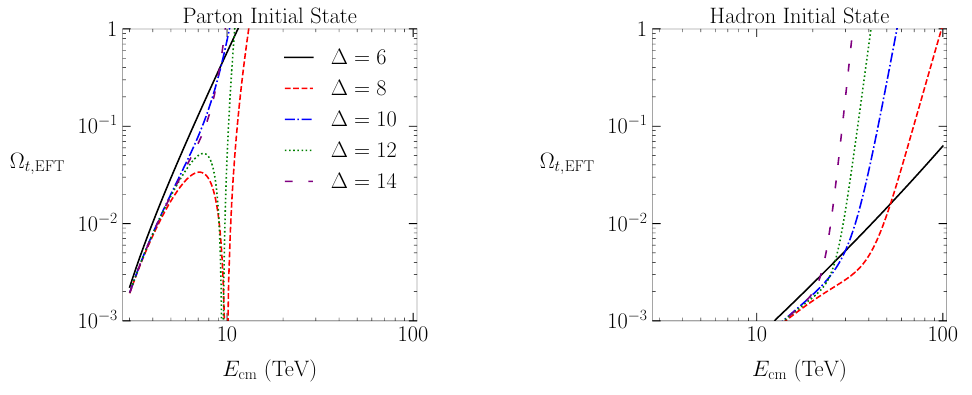
Figure 5 . Ω t, EFT computed using the EFT expansion of the t -channel model as a function of the center-of-mass energy E cm , for low choices of the truncation dimension ∆ = 6 + 2 k . For the Partonic Initial State case [left], when ∆ > 0 , Ω t, EFT grows at large E cm and approaches infinity as E cm → ∞ . This tells us there will be a perturbative unitarity cutoff for a critical value of E cm . In the Hadronic Initial State case [right], the growth of Ω t, EFT is significantly delayed as compared to the partonic